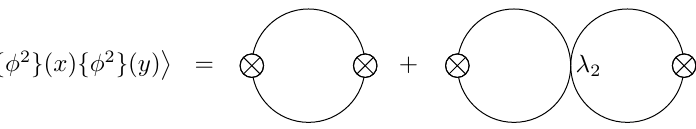
Figure 9 . Leading order diagrams for